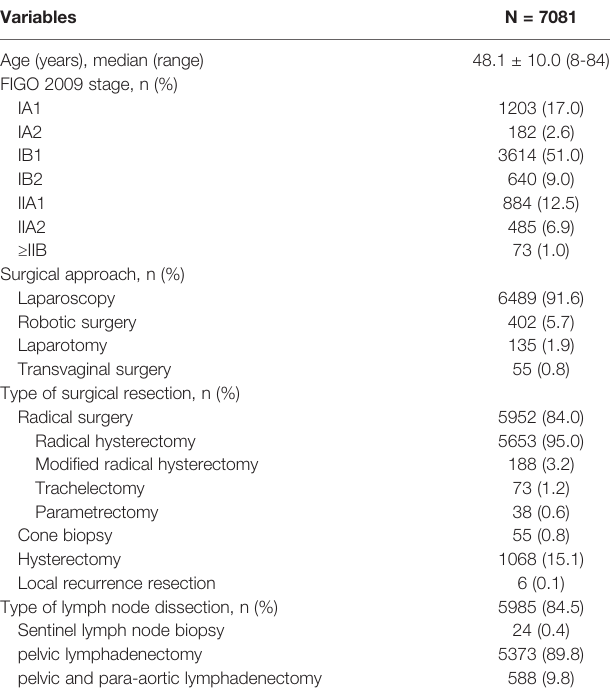
TABLE 1 | Clinical characteristic of patients with cervical cancer in different years. Variables N =